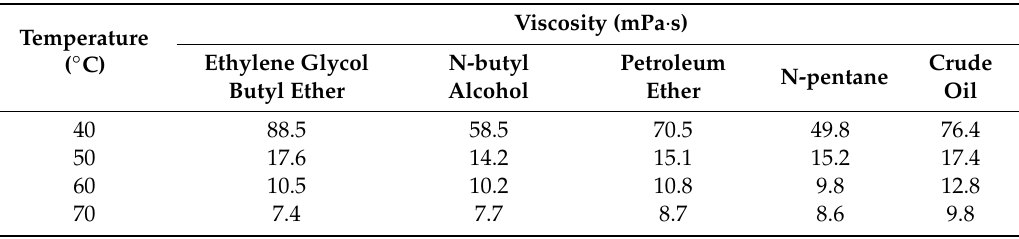
Table 3. Oil viscosities for the diluted crude oil with di ff erent hydrocarbon agents and undiluted crude oil under di ff erent